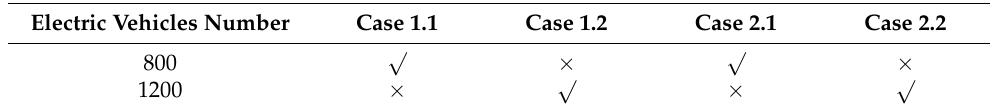
Figure 4. The net load forecast. Table 2. The different cases in